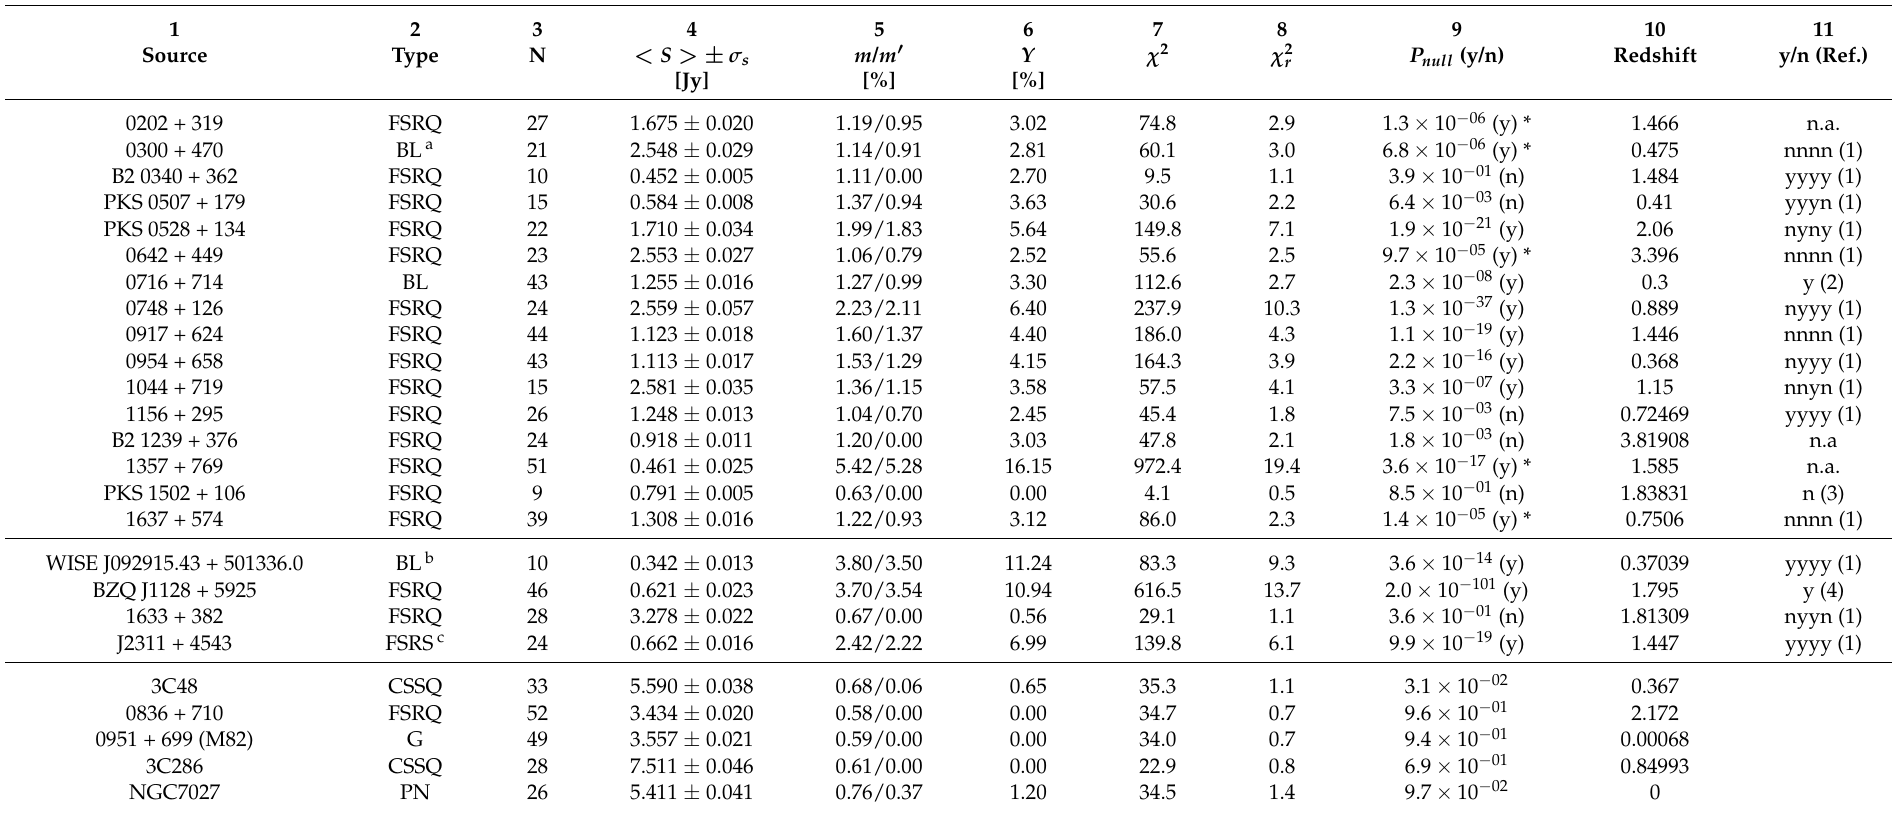
Table 1. The result of the IDV observation in 8–12 February 2014 with Urumqi 25 m telescope at 4.8 GHz. The columns are: (1) name; (2) source type (FSRQ: flat spectrum radio quasar, BL: BL Lac object, CSSQ: compact steep spectrum quasar, G: galaxy, PN: planetary nebula), most target sources’ type can be found in [31], except three targets with additional references in footnote; (3) number of flux density measurements; (4) mean flux density with the standard deviation; (5) modulation index m and modified modulation index m (cid:48) ; (6) relative variability amplitude Y ; (7), (8) χ 2 and reduced χ 2 ; (9) the null probability (a probability that the light curve can be fitted with a constant value) and with detected IDV (y) or not (n) in the bracket; (10) redshift of source; (11) previously detected IDV (y) or not (n) with relative reference in the bracket, or no available observation/publication found (n.a.). The sources in the first part